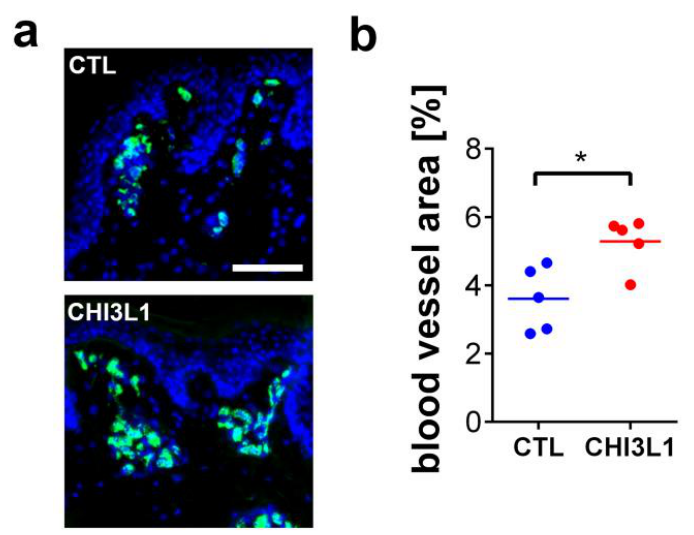
Figure 8. Treatment of porcine skin with 400 ng/mL recombinant CHI3L1 promoted angiogenesis ex vivo. ( a ) Representative immunofluorescence images of skin samples treated either with PBS (CTL) or CHI3L1. Nuclei were stained with DAPI (blue) and blood vessels were identified by staining of von Willebrand factor (green). Scale bar = 100 µm. ( b ) Quantitative analysis of the blood vessel area 48 h after treatment with CHI3L1. n = 5; * p ≤ 0.05 Student’s t -test.